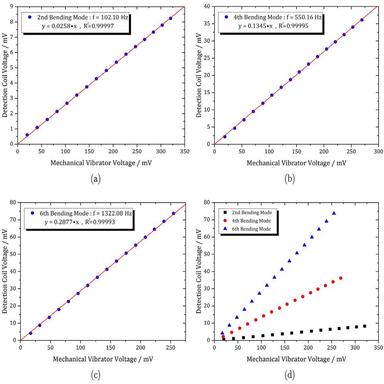
Metglas ribbons linearity graphs through the (a) 2nd, (b) 4th and (c) 6th bending modes of the cantilever beam. (d) Linearity comparison plot for all bending modes.